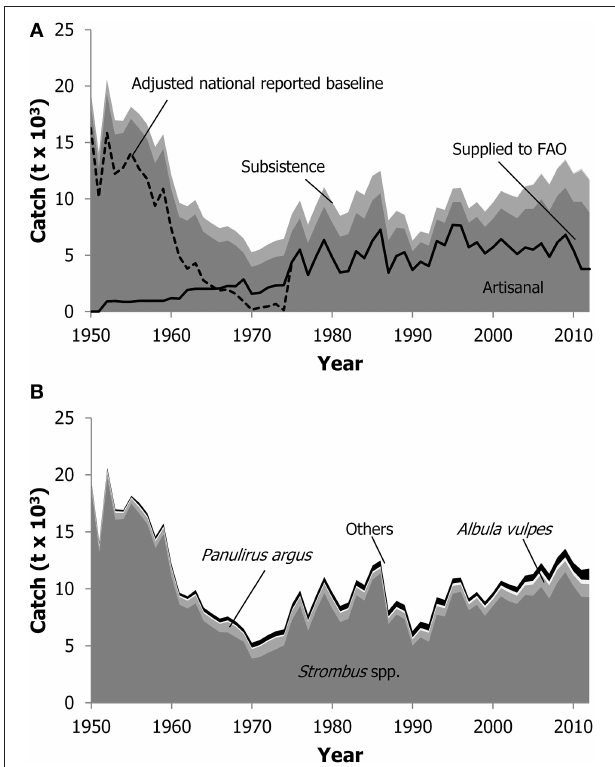
FIGURE 3 | (A,B) Time-series of reconstructed domestic marine catches for Turks and Caicos Islands by (A) fishing sector (recreational is too small to show), with data reported by FAO on behalf of the TCI, as well as the adjusted national reported data overlaid as dashed lines; and (B) by major taxa, with the “others” grouping consisting of 20 additional